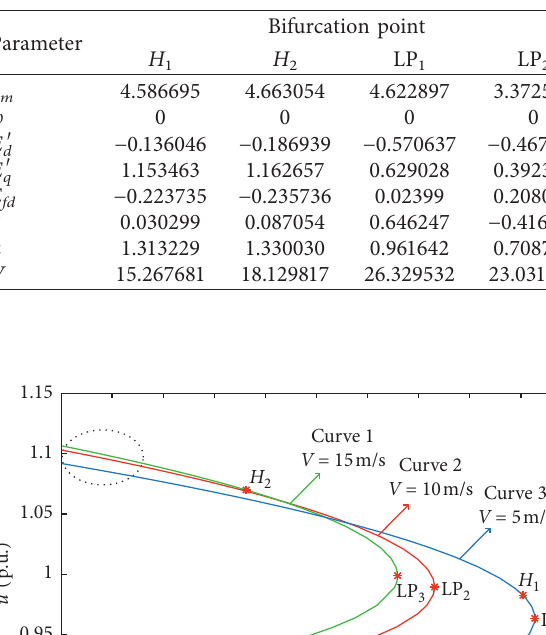
Table 3: The parameter value of each bifurcation point.